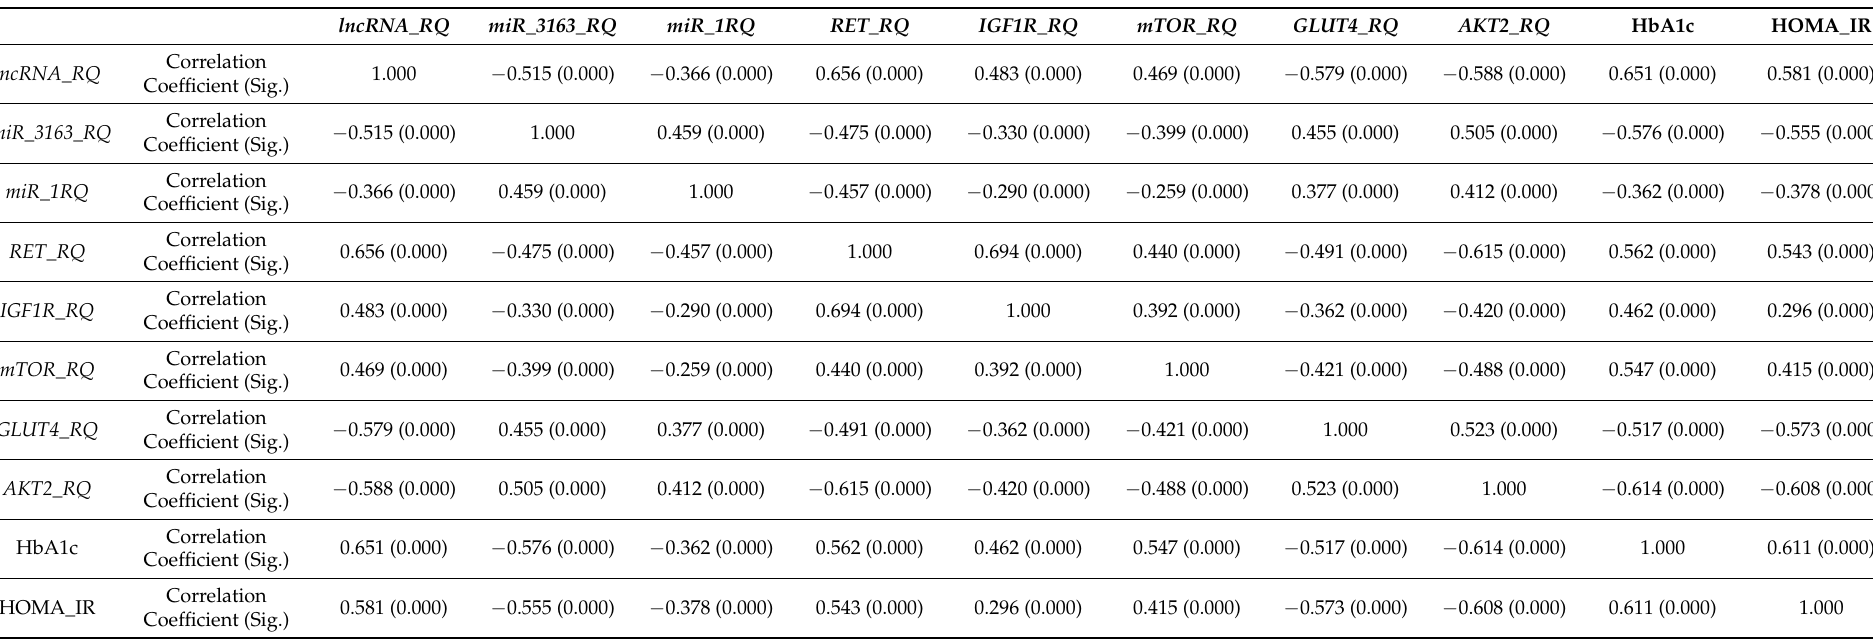
Table 3. Correlation between the investigated parameters expression in both the diabetic and healthy groups ( n =